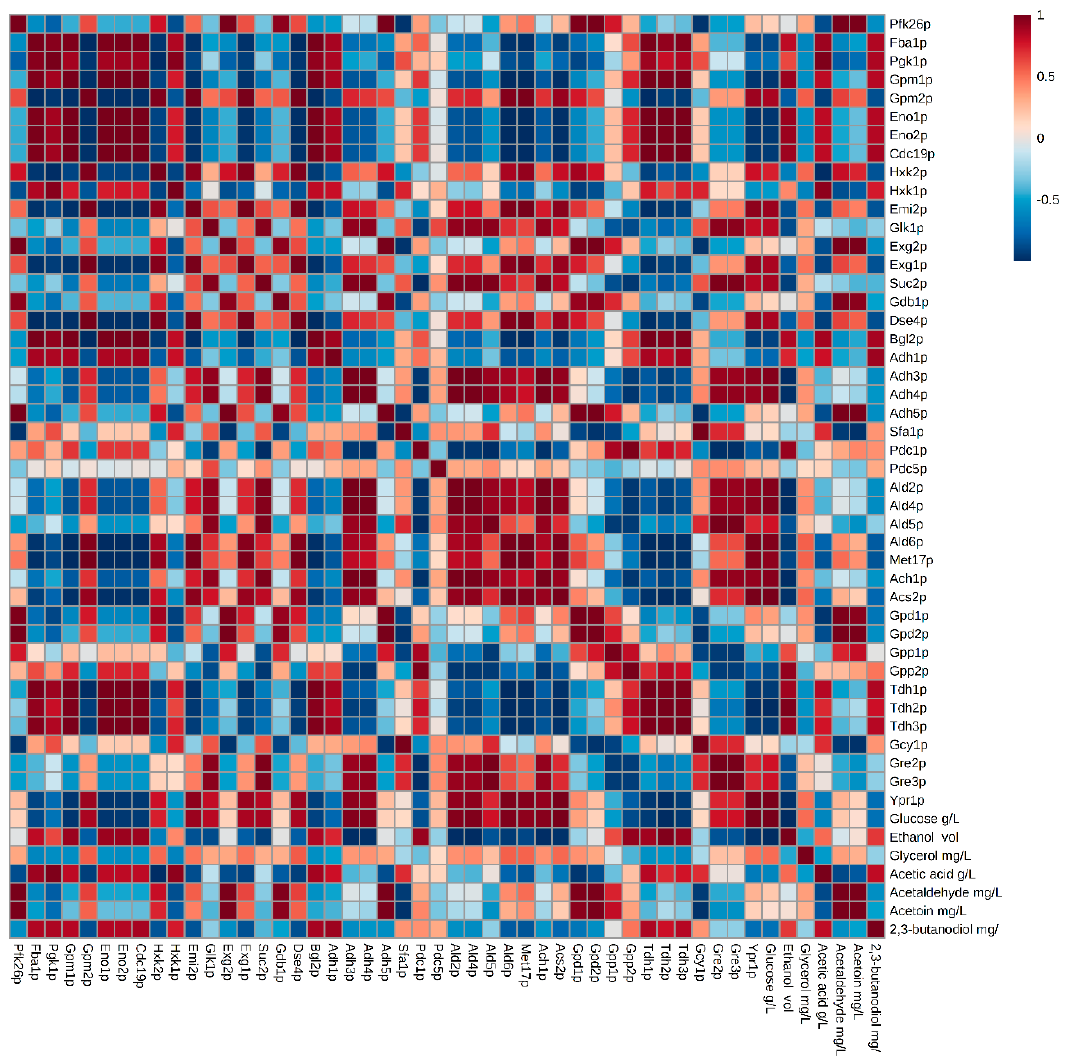
Figure 3. Matrix of correlations established between proteins and compounds released in the second fermentation in the conventional yeast P29 strain. Metabolome data extracted from Martínez-García et al. (2017) [25].